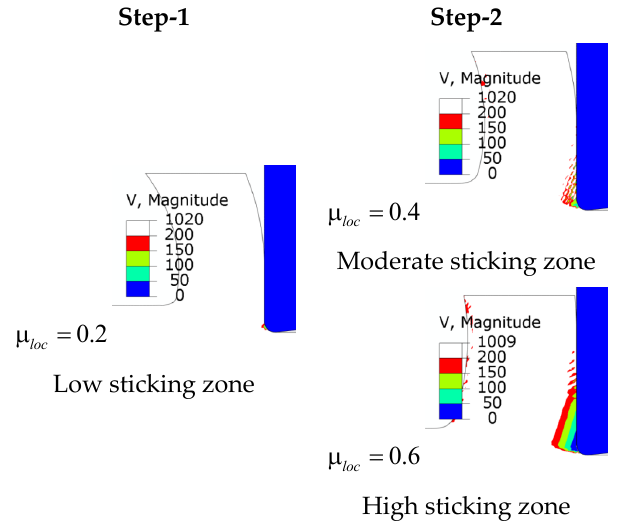
Figure 12. Effect of COF (coefficient of friction) on the material flow velocity at the tool ‐ chip interface.